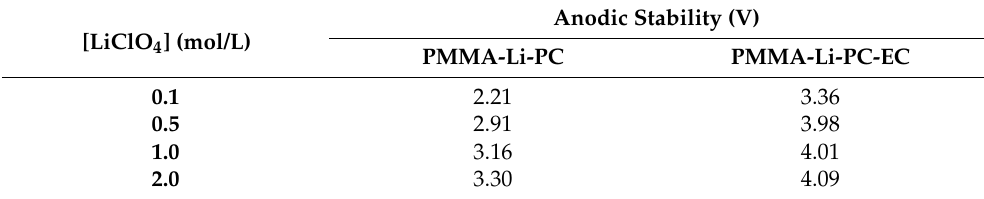
Figure 16. The Linear sweep voltammetry (black line) from 0 to 7 V and in the current range between 0 and 200 mA (scan rate 10 mV/s) and the anodic stability (relative linear fit, red line) of PMMA-Li-PC gel polymer electrolyte at different salt concentrations: 0.1 M, 0.5 M, 1 M and 2 M. Table 2. Anodic stability from 0 to 7 V and in the current range between 0 and 200 mA (scan rate 10 mV/s) of polymeric gel electrolyte at different salt concentrations: 0.1 M, 0.5 M, 1 M and 2 M. Anodic Stability (V) [LiClO 4 ] (mol/L)